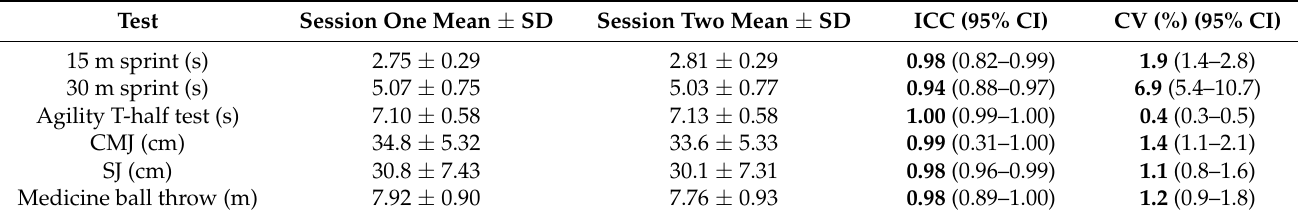
Table 1. Physical fitness tests obtained from two sessions two weeks apart ( n = 31). Descriptive statistics (mean ± standard deviation (SD)) and intrarater reliability are presented for each test. Intraclass correlation coefficient (ICC) ≥ 0.75 and coefficient of variation (CV) ≤ 10% are highlighted in